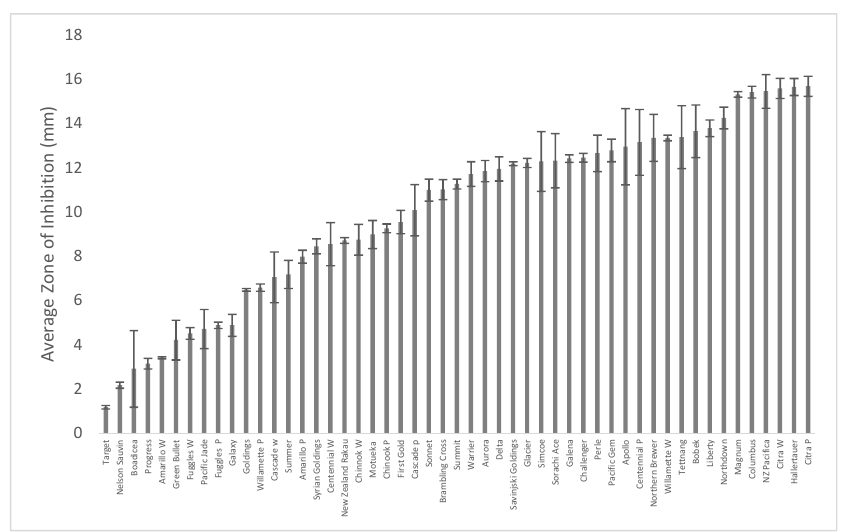
Figure 1. The average zone of inhibition of aqueous hop extracts ( n = 50) against M. bovis BCG. Experiments are the results of 3 replicates on three occasions +/− standard deviation. ( p = Pelleted variant; W = Whole; unstated = whole).